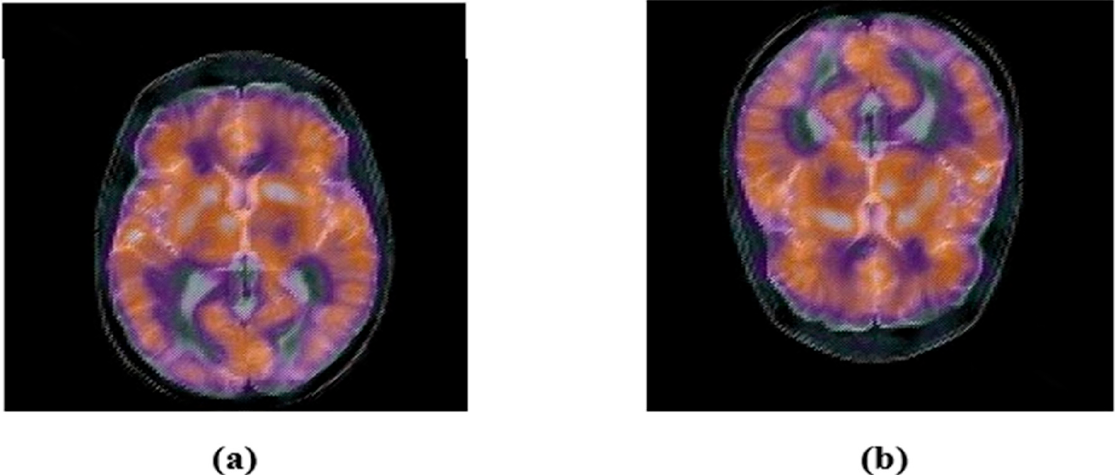
Figure 11. Image after flipping attacks: ( a ) Horizontal-flipping, PSNR = 8.9862, ( b ) Vertical-flipping, PSNR = 12.5725.